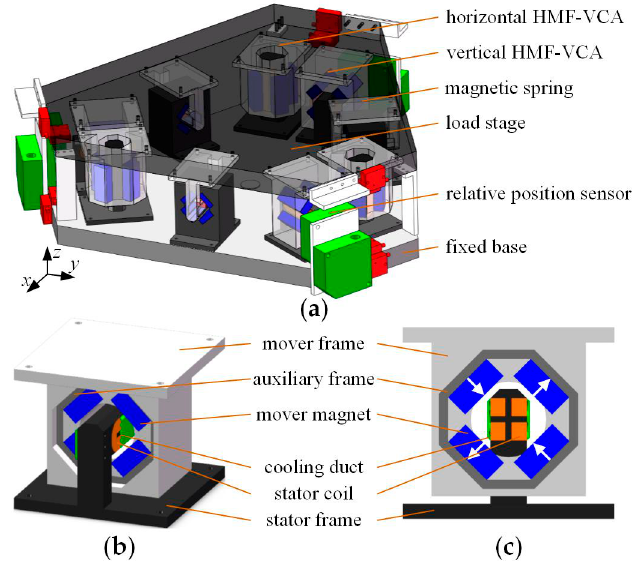
Figure 1. Structure of the HMF-VCA and MLFPS. ( a ) 3-D view of the MLFPS. ( b ) 3-D view of the HMF-VCA. ( c ) Sectional view of the HMF-VCA.